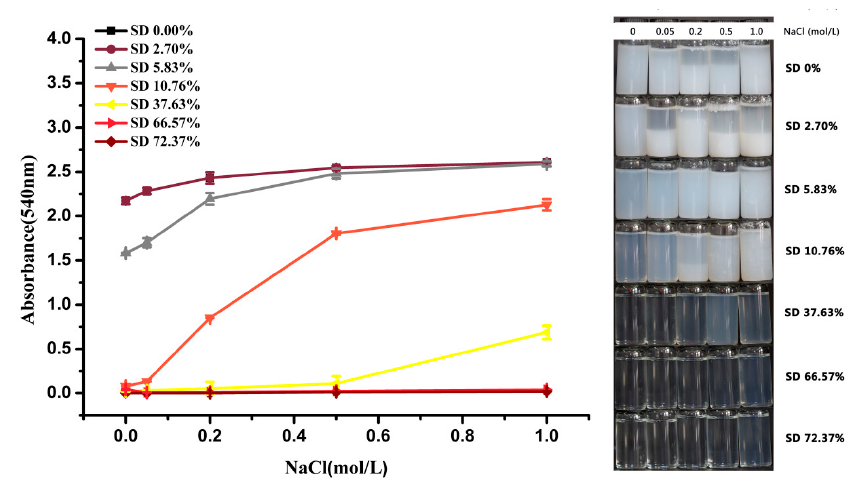
Figure 2. Changes in turbidity of egg white protein (EWP) and succinylated egg white protein (SEWP) solution (5 mg/mL) heated at 90 °C for 30 min. at various NaCl concentrations (0.0–1.0 mol/L).